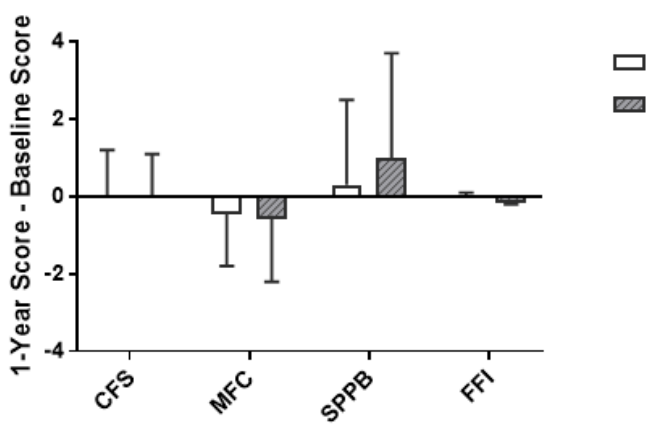
Figure 3. ∆ Frailty scores from baseline to 1-year post-operatively. Values are mean ± standard deviation. Completers n = 48; non-completers n = 66. Statistical comparisons were calculated using a non-parametric Mann-Whitney test. CFS, Clinical Frailty Scale; MFC, Modified Fried Criteria; SPPB, Short Physical Performance Battery; FFI, Functional Frailty Index.